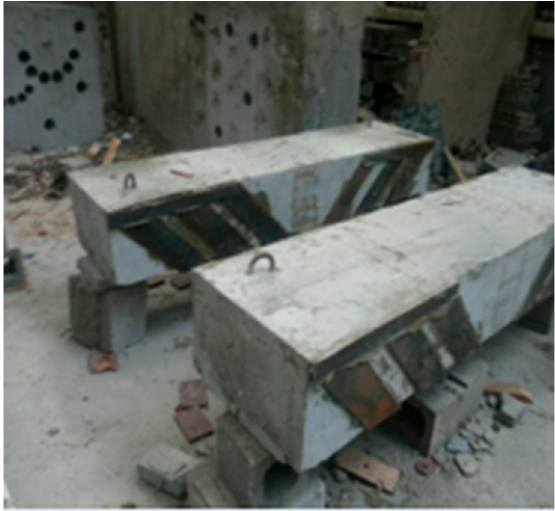
Figure 7. Construction drawing of the test beam strengthened by pasting steel